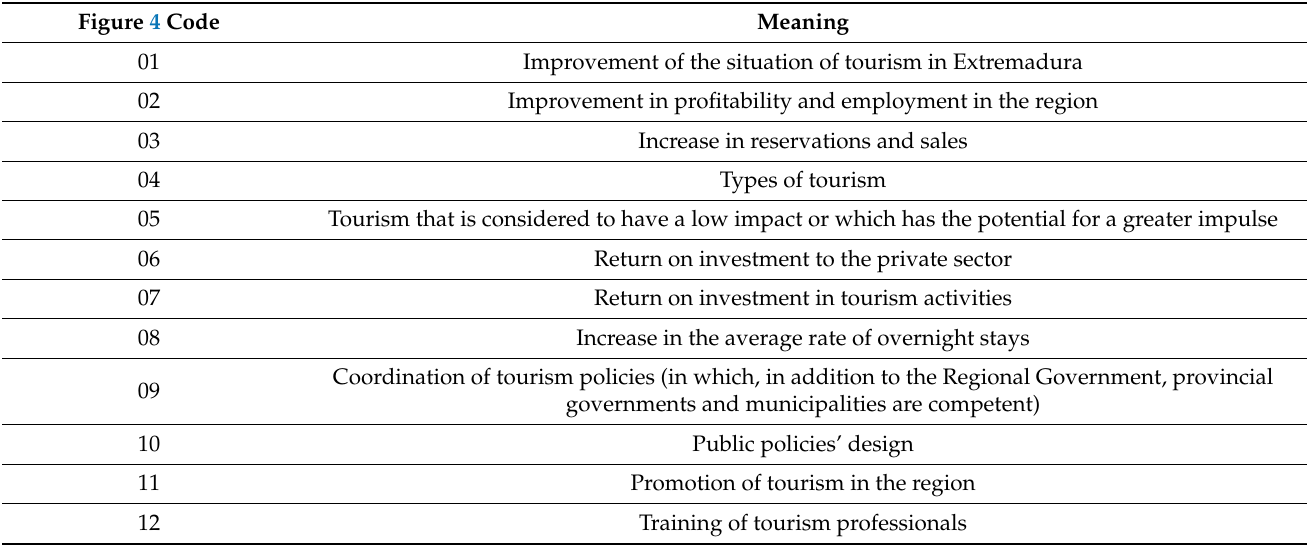
Table 6. Figure 4 codes interpretation.